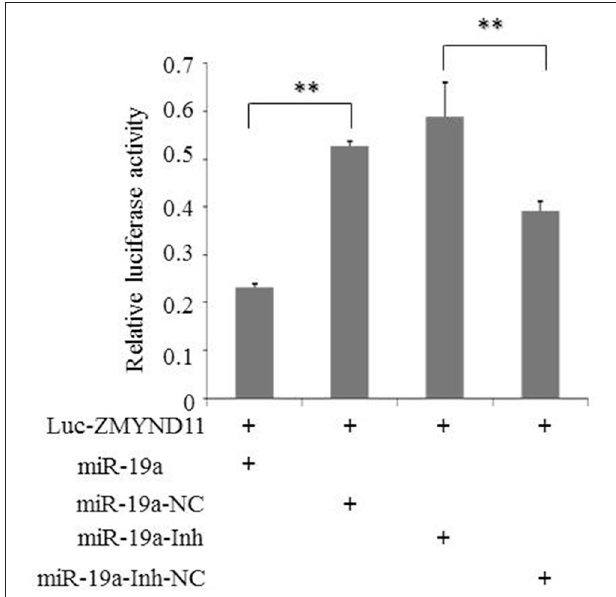
FIGURE 2 | Gga-miR-19a directly targets to ZMYND11 . DF-1 cells were co-transfected with Luc- ZMYND11 (3 ′ -UTR) and the indicated RNA oligonucleotides. Luciferase activity was assayed at 24 h post-transfection. The firefly luciferase activity of each sample was normalized to the Renilla luciferase activity. All values are represented as the mean ± SD of three independent experiments in triplicate and were analyzed by Student’s t -test. Significant differences are denoted as ** P <